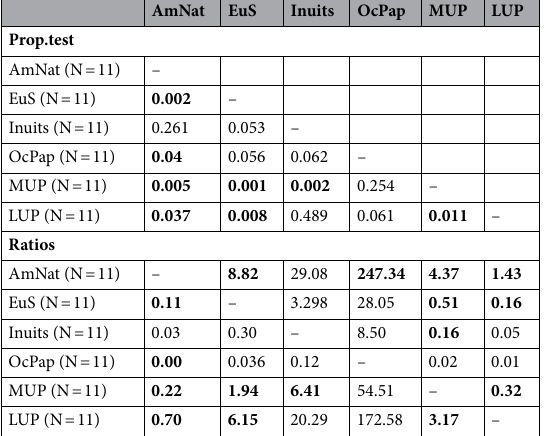
Table 6. Covariance matrices ML proportionality test and ratios of generalized variances between groups based on the entire sample. Significant results ( p < 0.05) are shown in bold and are the only results discussed in the text.